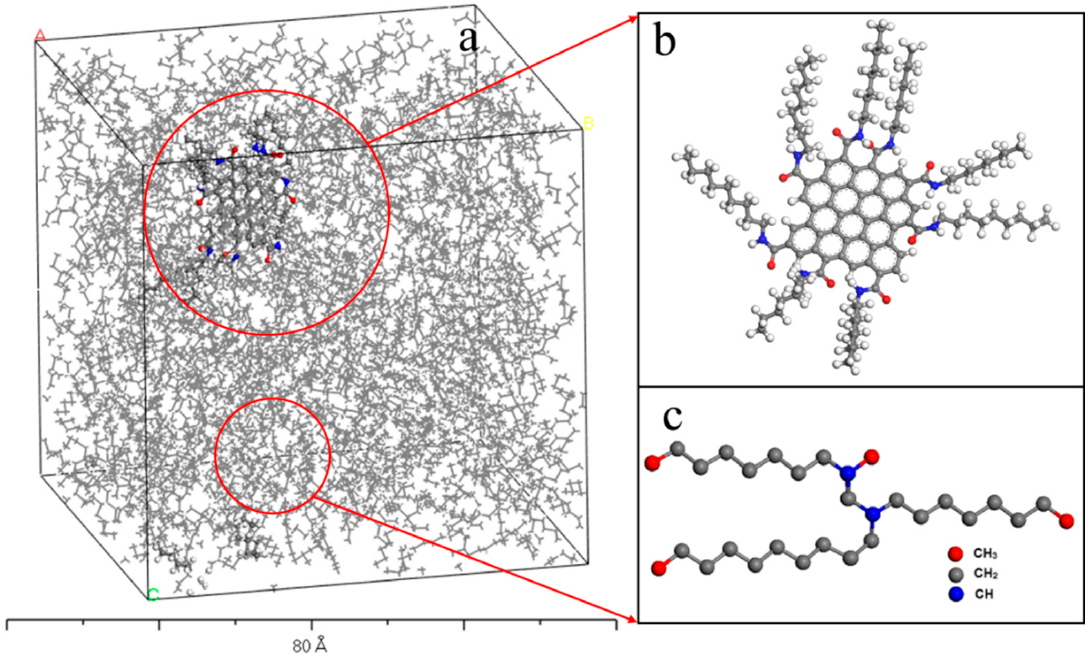
Figure 1. Snapshot of EMD simulation of ( a ) nanofluid cell with ( b ) graphene and ( c ) 1-decene trimer molecules.